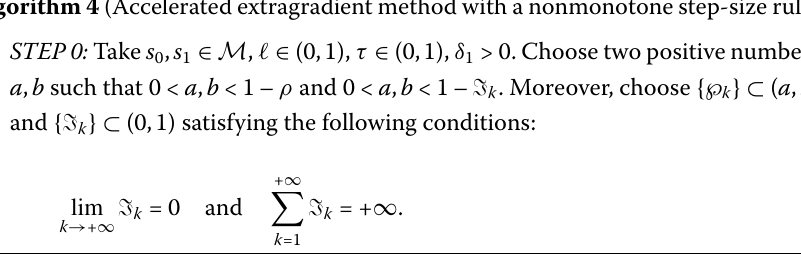
Algorithm 4 (Accelerated extragradient method with a nonmonotone step-size